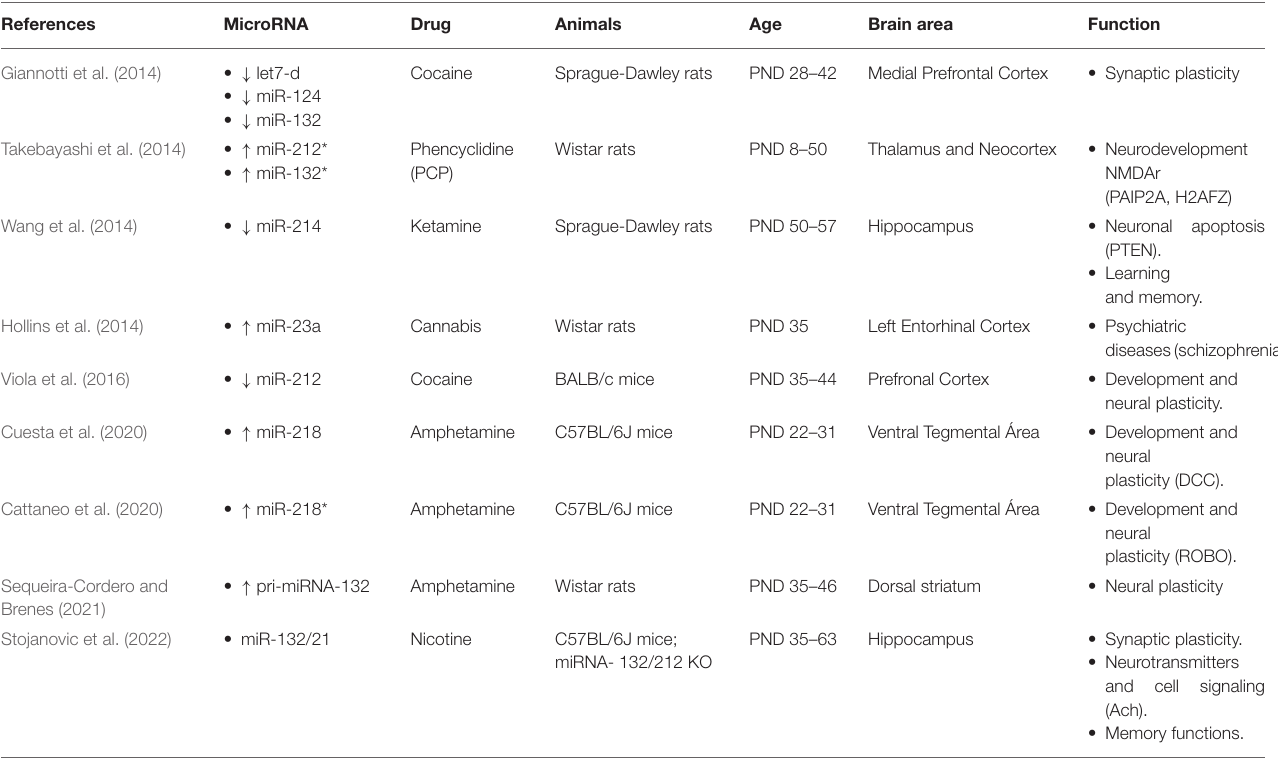
TABLE 2 | Effect of drug abuse on brain miRNA expression and